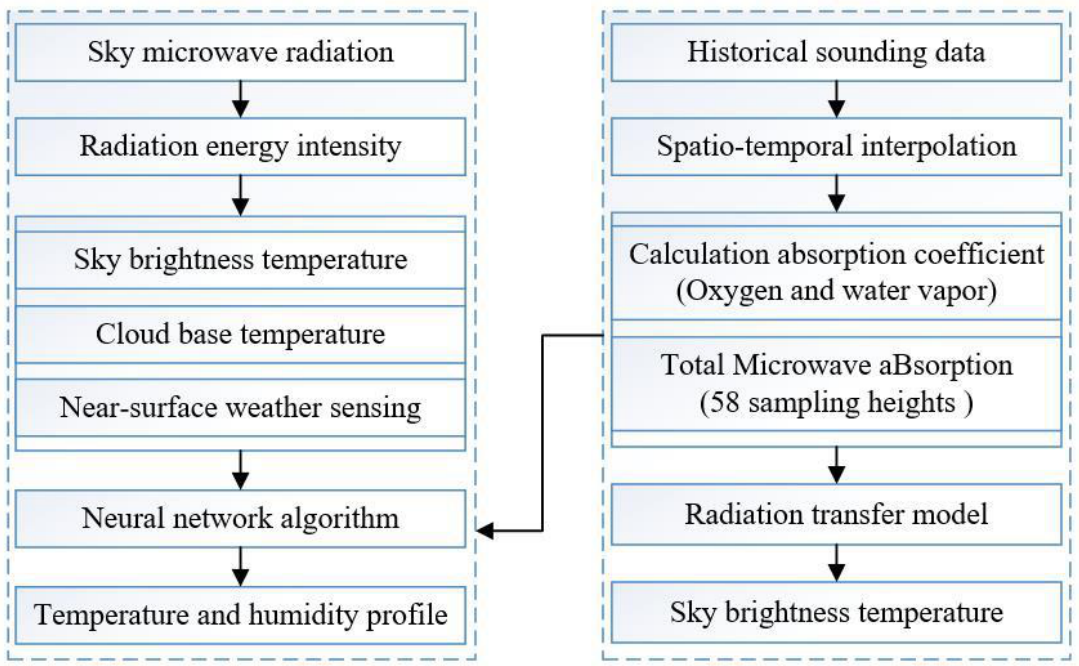
Figure 2. Flow chart of remote sensing atmospheric detection by MWR.